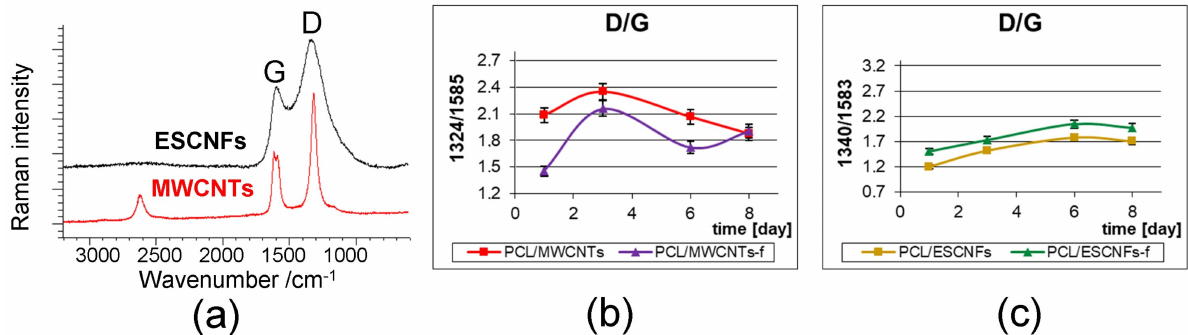
Figure 7. ( a ) Raman spectra of MWCNTs and CNFs nanoadditives (reference spectra), in the range 3200–500 cm − 1 ; the I(D)/I(G) intensity ratio for: ( b ) PCL/MWCNTs, PCL/MWCNTs-f; (Statistical analysis with PCA with Calibration 99.86237%; Validation 99.14962%) ( c ) PCL/ESCNFs and PCL/ESCNFs-f, (Statistical analysis with PCA with Calibration 99.86559%; Validation 99.01482%) polymer nanomaterials constituting the substrate for U-2 OS cell culture, in the following days of culture; 785 nm excitation line, variance is defined by y-axis error bars, OMNIC